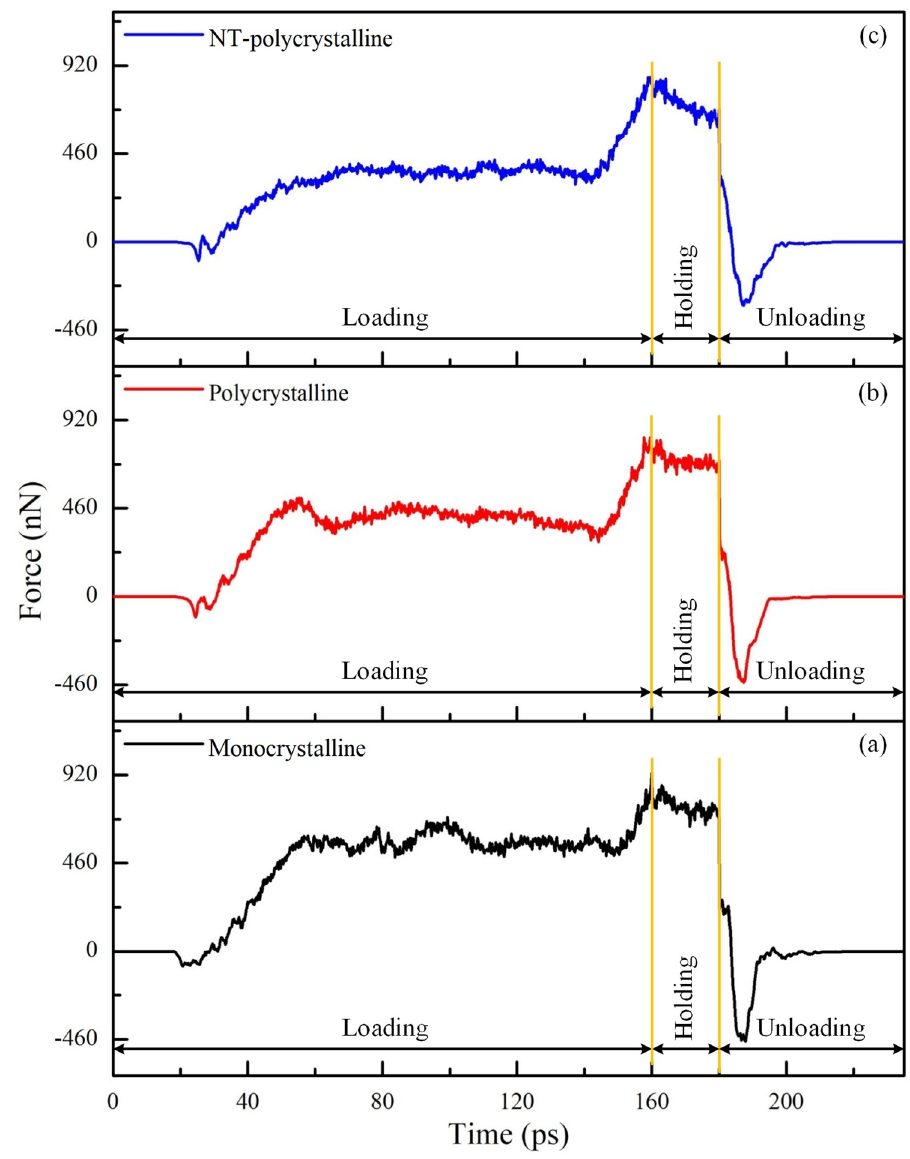
Figure 2. The imprinting force curves of Al0.5 HEA during the nanoimprinting for various crystal structures: monocrystalline ( a ); polycrystalline ( b ); NT-polycrystalline ( c